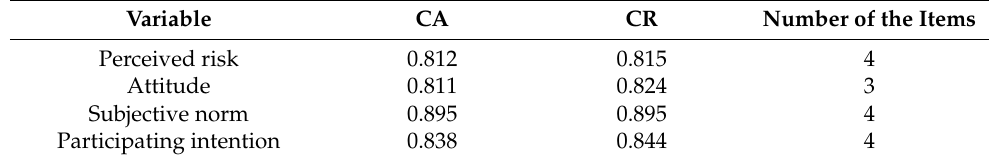
Table 3. Reliability analysis